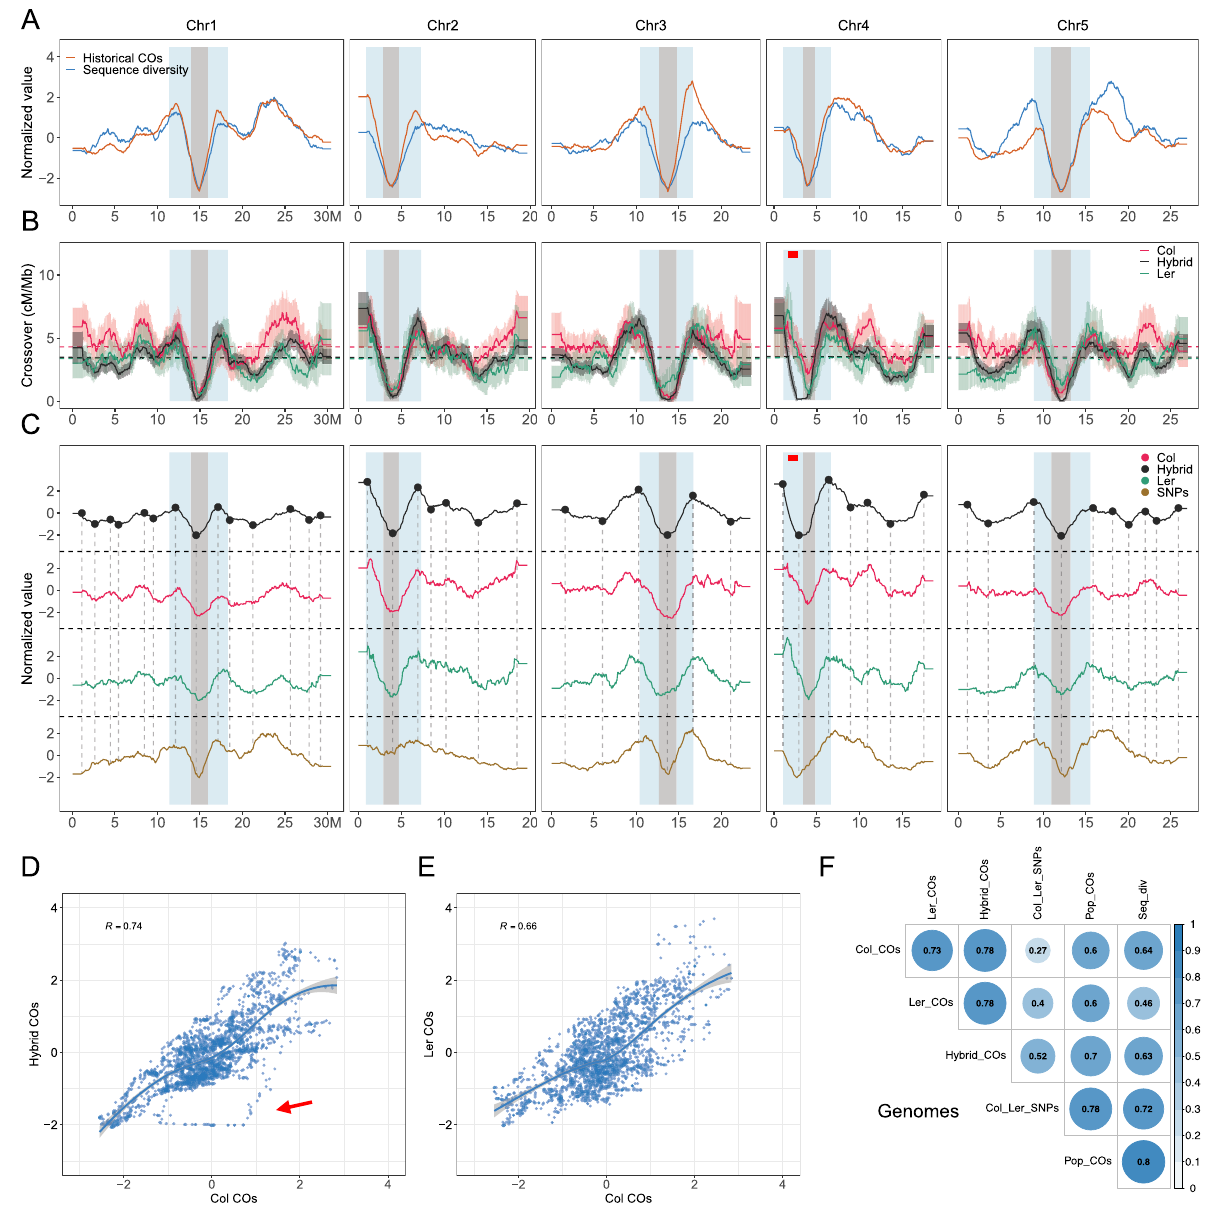
Fig. 3 Comparison of the genome-wide CO landscape in Col, L er , and F2 hybrids with genetic polymorphisms. A The normalized landscapes (sliding window-based, window size 2 Mb and step size 50 kb) of historical recombination rate (4Ner per kb, red) and sequence diversity ( π , blue) within 2029 Arabidopsis accessions across genomes. B The chromosomal distribution of COs, with 90% con fi dence interval in Col, L er (merged female and male), and Col/Ler F2 hybrids. The genome-wide mean-level recombination is shown with dashed lines. C The z-score-normalized distribution of COs in Col, L er , and F2 hybrids and the density of SNPs between Col and L er along chromosomes. The relative crossover frequency (the number of crossovers in the given window divided by the total crossover number within the respective chromosome) was calculated for each individual chromosome. The peaks and valleys detected in the hybrid landscape are represented by black points prolonged by vertical dashed lines. The pericentromeric and centromeric regions are indicated by grey and blue shading, separately. The ∼ 1.2 Mb inversion between Col and L er on chromosome 4 is represented by a red bar. D , E Spearman ’ s correlation analysis of the normalized distribution of COs in Col, L er and Col/L er F2 hybrids. The red arrow points to the effect of the ~1.2 Mb inversion between Col and L er on chromosome 4, which is only present in the comparison between inbred lines and hybrids. F The non-linear correlation coef fi cient matrices among genome-wide distributions. Col_COs, Ler_COs, Hybrid_Cos and pop_COs represent CO landscapes in Col, L er , F2 hybrids and the population of 2029 Arabidopsis accessions (historical recombination rate); SNPs represents SNP density between Col and L er , and Seq_div represents sequence diversity in the population of 2029 Arabidopsis accessions. Source Data are provided as a Source Data fi le.